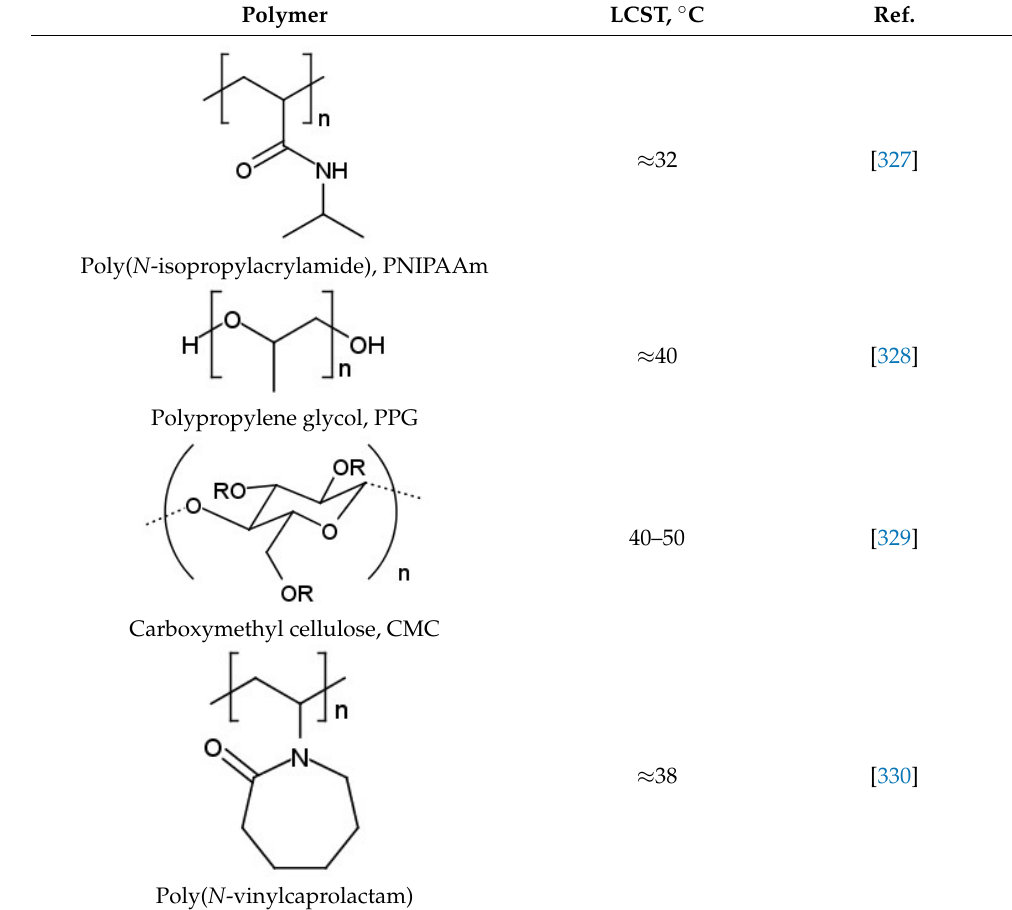
Table 2. The LCST of polymers in an aqueous solution. Polymer LCST, ◦ C